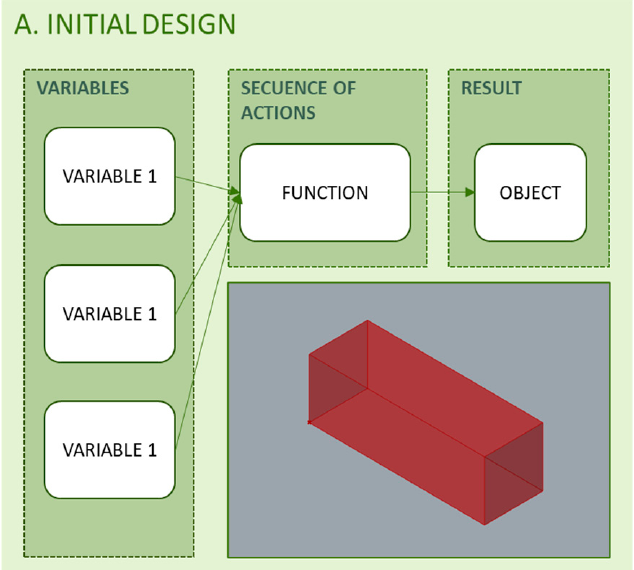
Figure 8. Programming structure for the configuration of the initial volumetric design.